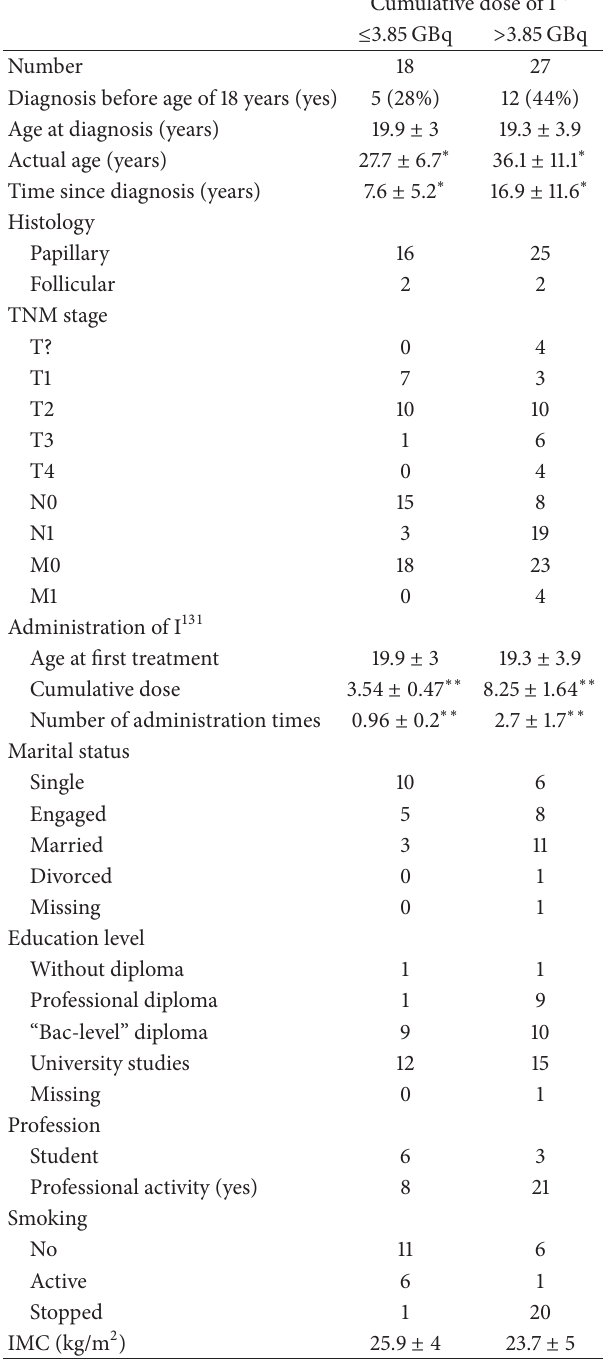
Table 1: Clinical and demographic characteristics of patients diag- nosed and treated with differentiated thyroid cancer before age of 25 years.